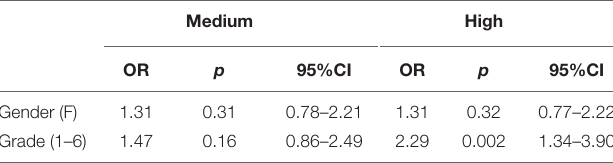
TABLE 4 | Ordinal logistic regression of factors influencing the latent classes of psychological